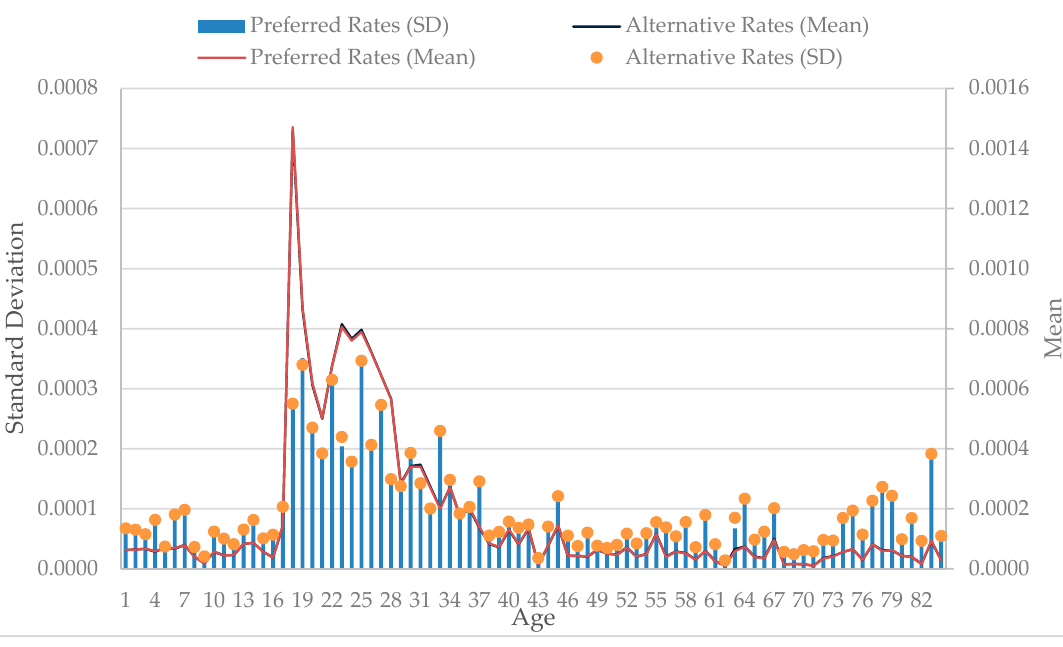
Figure 4. Means and Standard Deviations of Female Domestic In-Migration Rate, 2007–2014. Source: 2006–2014 1-Year American Community Survey.